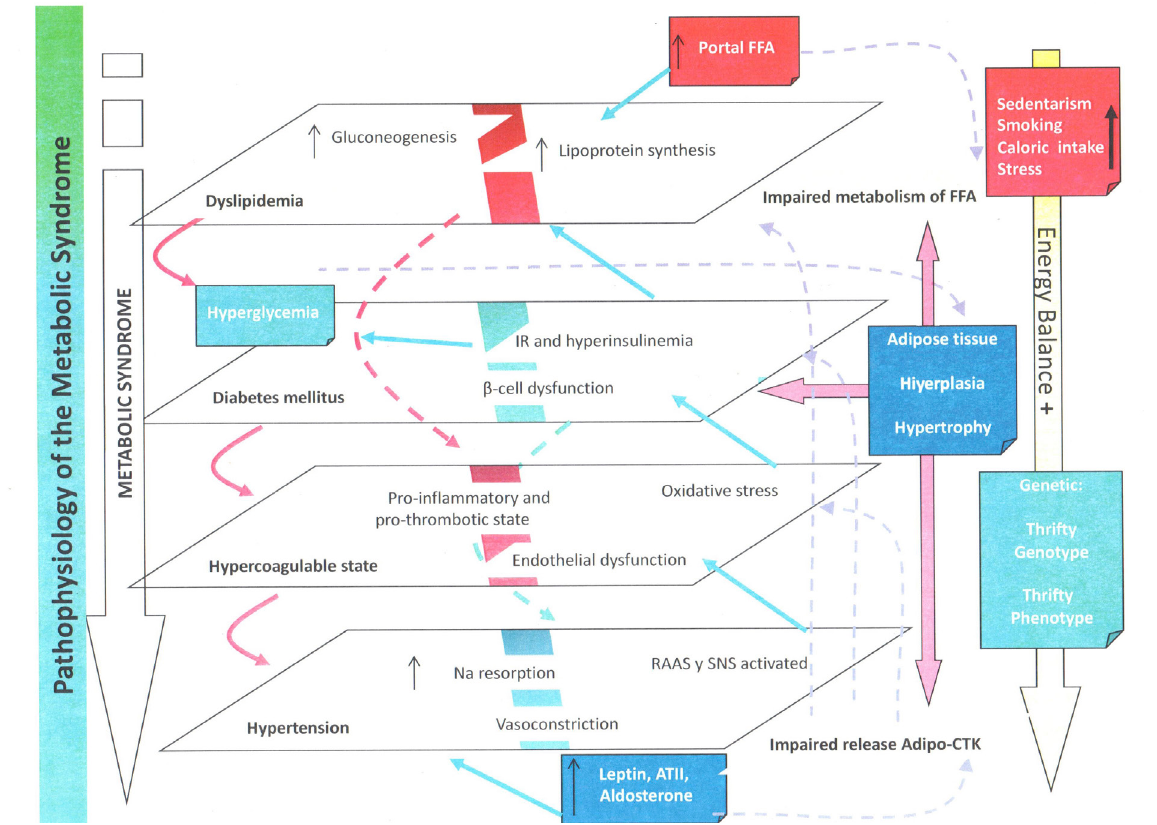
FIGURE 1 - A complex network of interactions that are culminating in the MetS. Several risk factors have been proposed; as sedentarism, smoke increased caloric intake and stress. These induce positive, energetic balance factors associated with con genetic factors (thrifty genotype or thrifty phenotype). All propitious hypertrophy and hyperplasia of the adipose tissue alter the metabolism of free fatty acids (FFA) and the release of adipocytokines (Adipo-CTK), affecting distinct organic systems, with increments in the FFA portal circulation, and in the levels of leptin, ATII and aldosterone. All this results in dyslipidemia, diabetes, hypercoagulable state, and hypertension. All of them affecting each other in a complex network of interactions that were culminating in the MetS. IR: insulin resistance; RAAS: Renin-Angiotensin-Aldosterone System; SNS Sympathetic Nervous System; ATII: Angiotensin